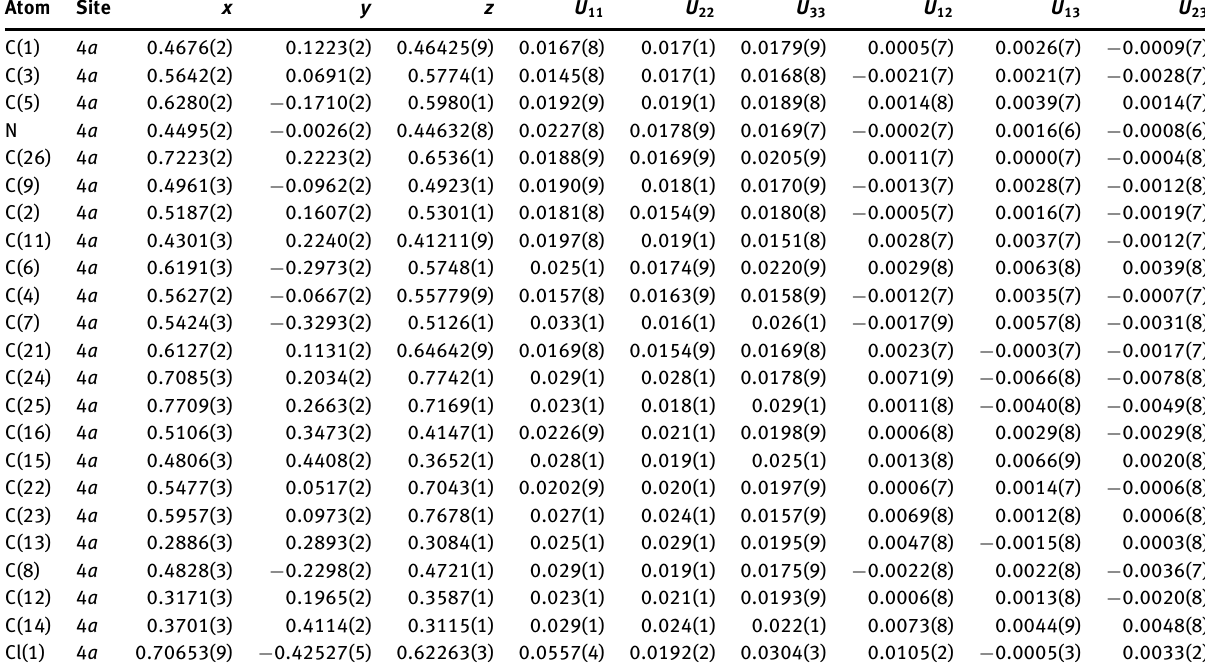
Table 3: Atomic displacement parameters (Å 2 ).